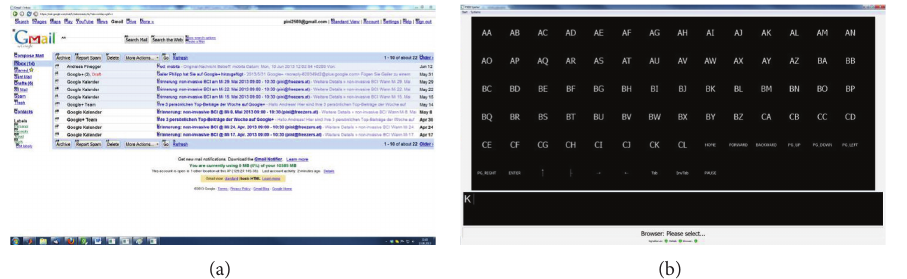
Figure 12: Screenshot of the Gmail home page (a) and the P300 controller (b).